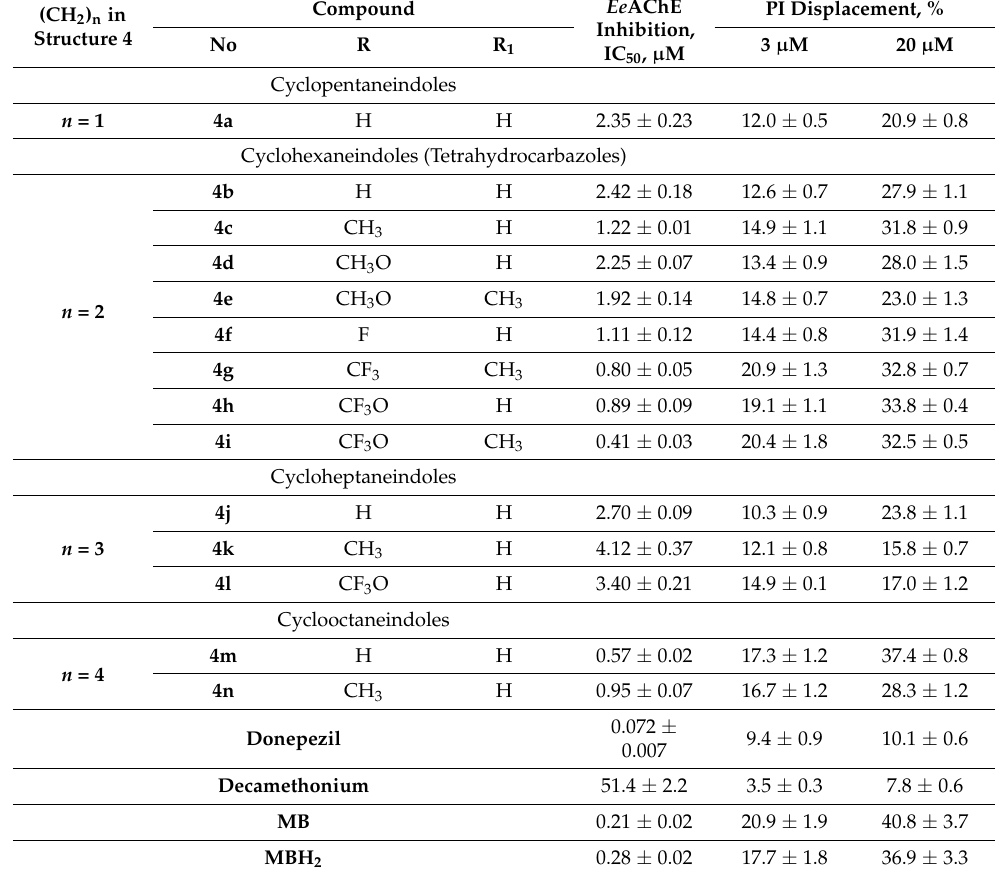
Table 2. Inhibitory activity of MB -cycloalkaneindoles conjugates 4 against Ee AChE and their ability to displace PI from the Ee AChE PAS 1